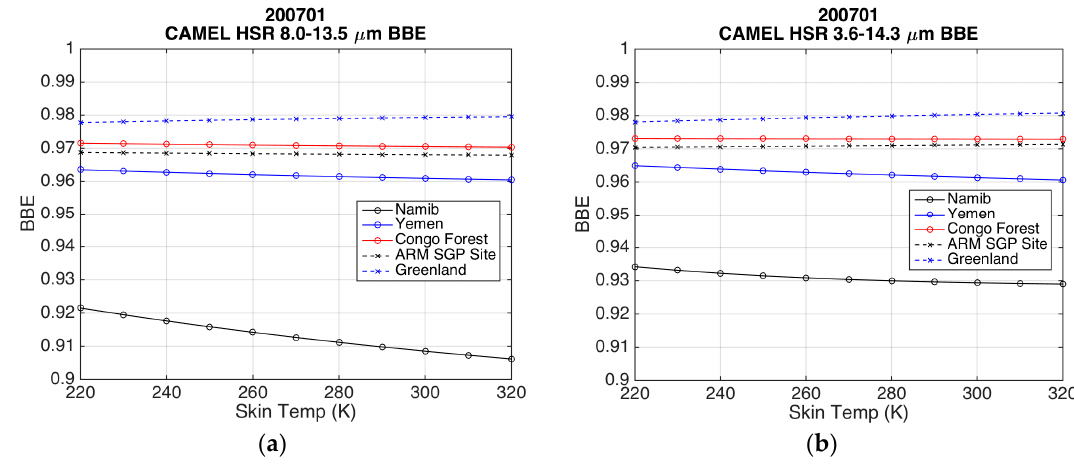
Figure 2. January 2007 CAMEL high spectral resolution (HSR) broadband emissivity (BBE) dependence on skin temperature for 5 different case study sites for ( a ) the 8.0–13.5 µm region and; ( b ) the 3.6–14.3 µm region.